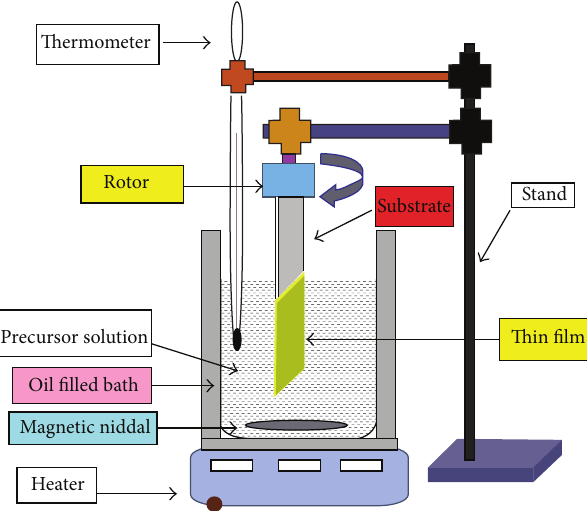
Figure 8: Schematic representation of chemical bath deposition method [71].